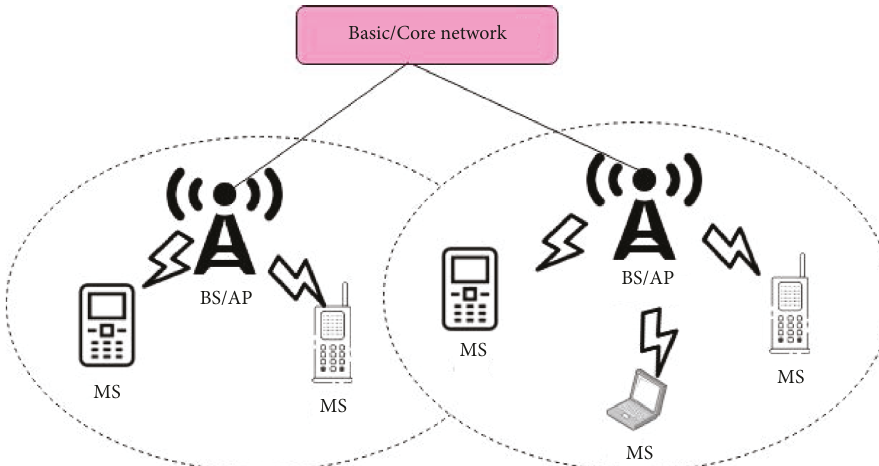
Figure 6: Infrastructure model.